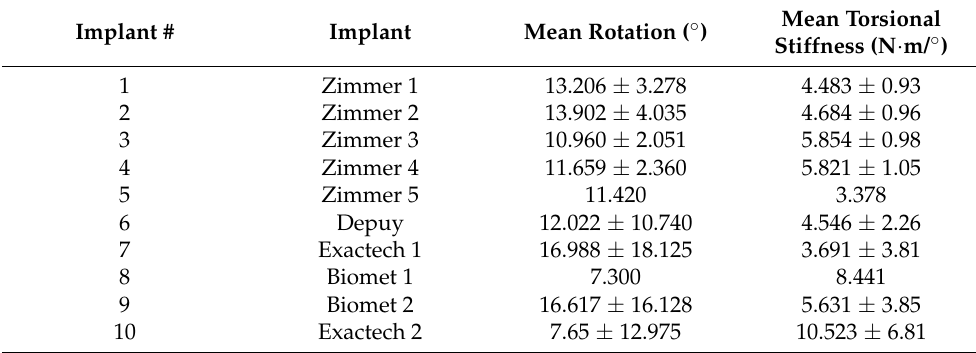
Table 3. Mean rotation and torsional stiffness for each implant.